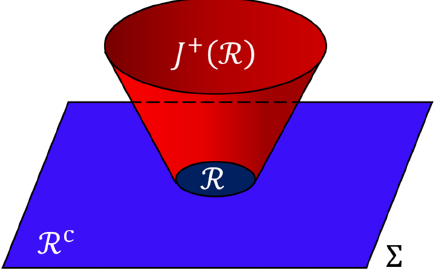
FIG. 1. Geometric visualization of the principle of causality. Take an arbitrary spacelike Cauchy 3D surface Σ . The simplest example of such a surface is the hyperplane f t ¼ 0 g . Divide Σ into two regions: R (dark blue) and R c (light blue). “ Paint in red ” all the timelike and lightlike curves that originate from R and propagate toward the future. The red paint will cover a set J þ ð R Þ called the “ domain of influence of R ” or “ causal future of R ” or “ future light cone of R . ” Causality demands the following: If we compare two arbitrary solutions (of the field equations) whose initial data differ on R but coincide on R c , such solutions can differ only inside J þ ð R Þ . This is equivalent to saying that information coming from R can never exit J þ ð R Þ